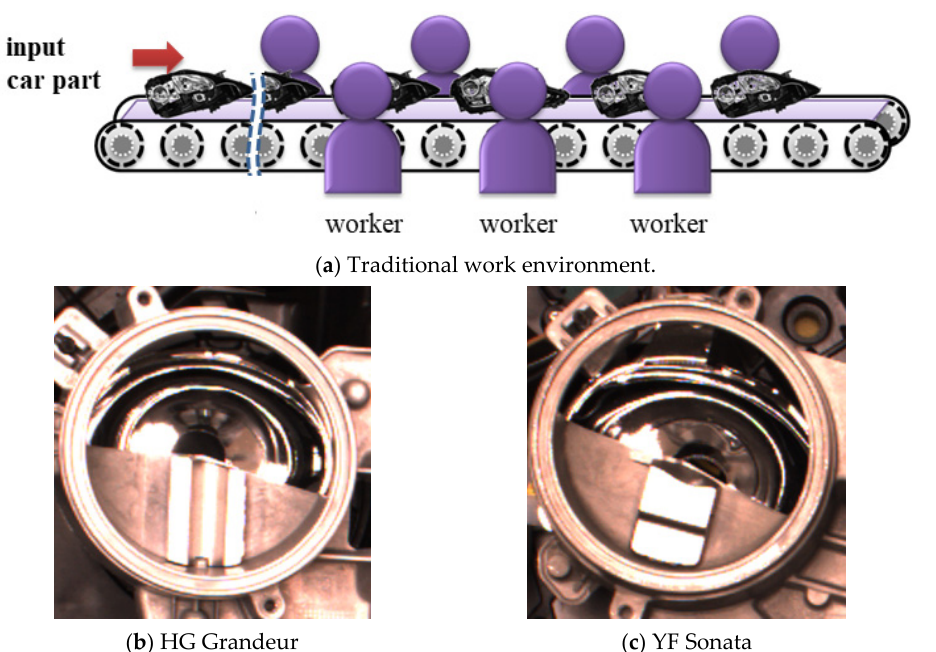
Figure 1. Traditional work environment and headlight images.